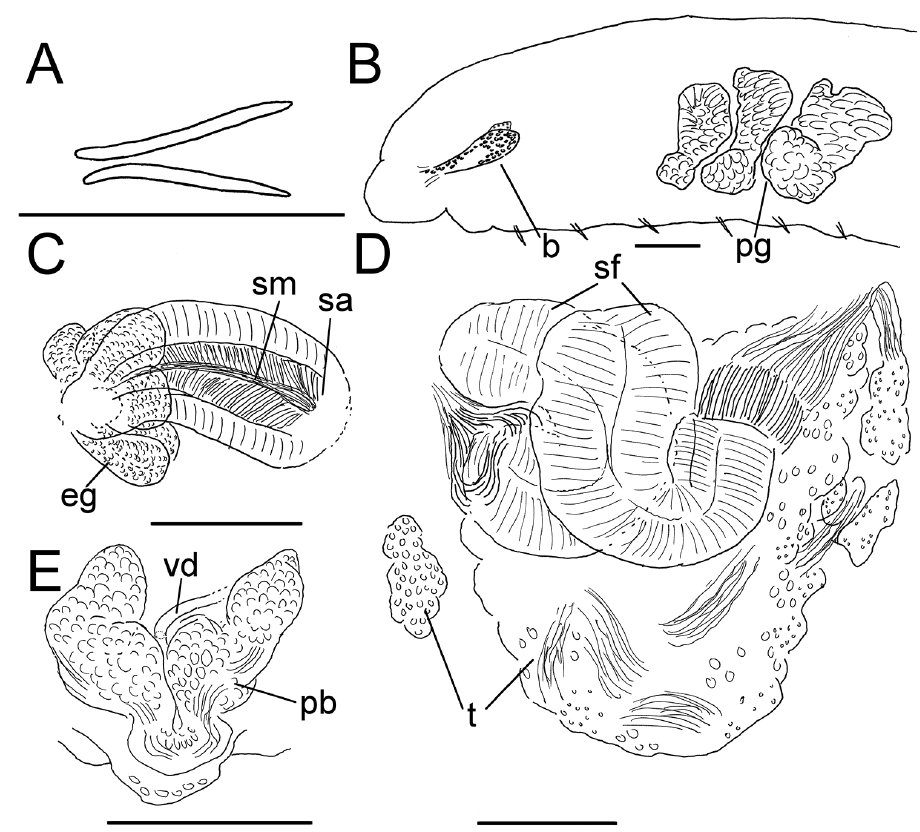
Figure 23. Lumbricillus dubius . A Chaetal bundle B Anterior body C Spermatheca D Male genitalia E Penial bulb. Abbreviations under general notes. Scale bars: 100